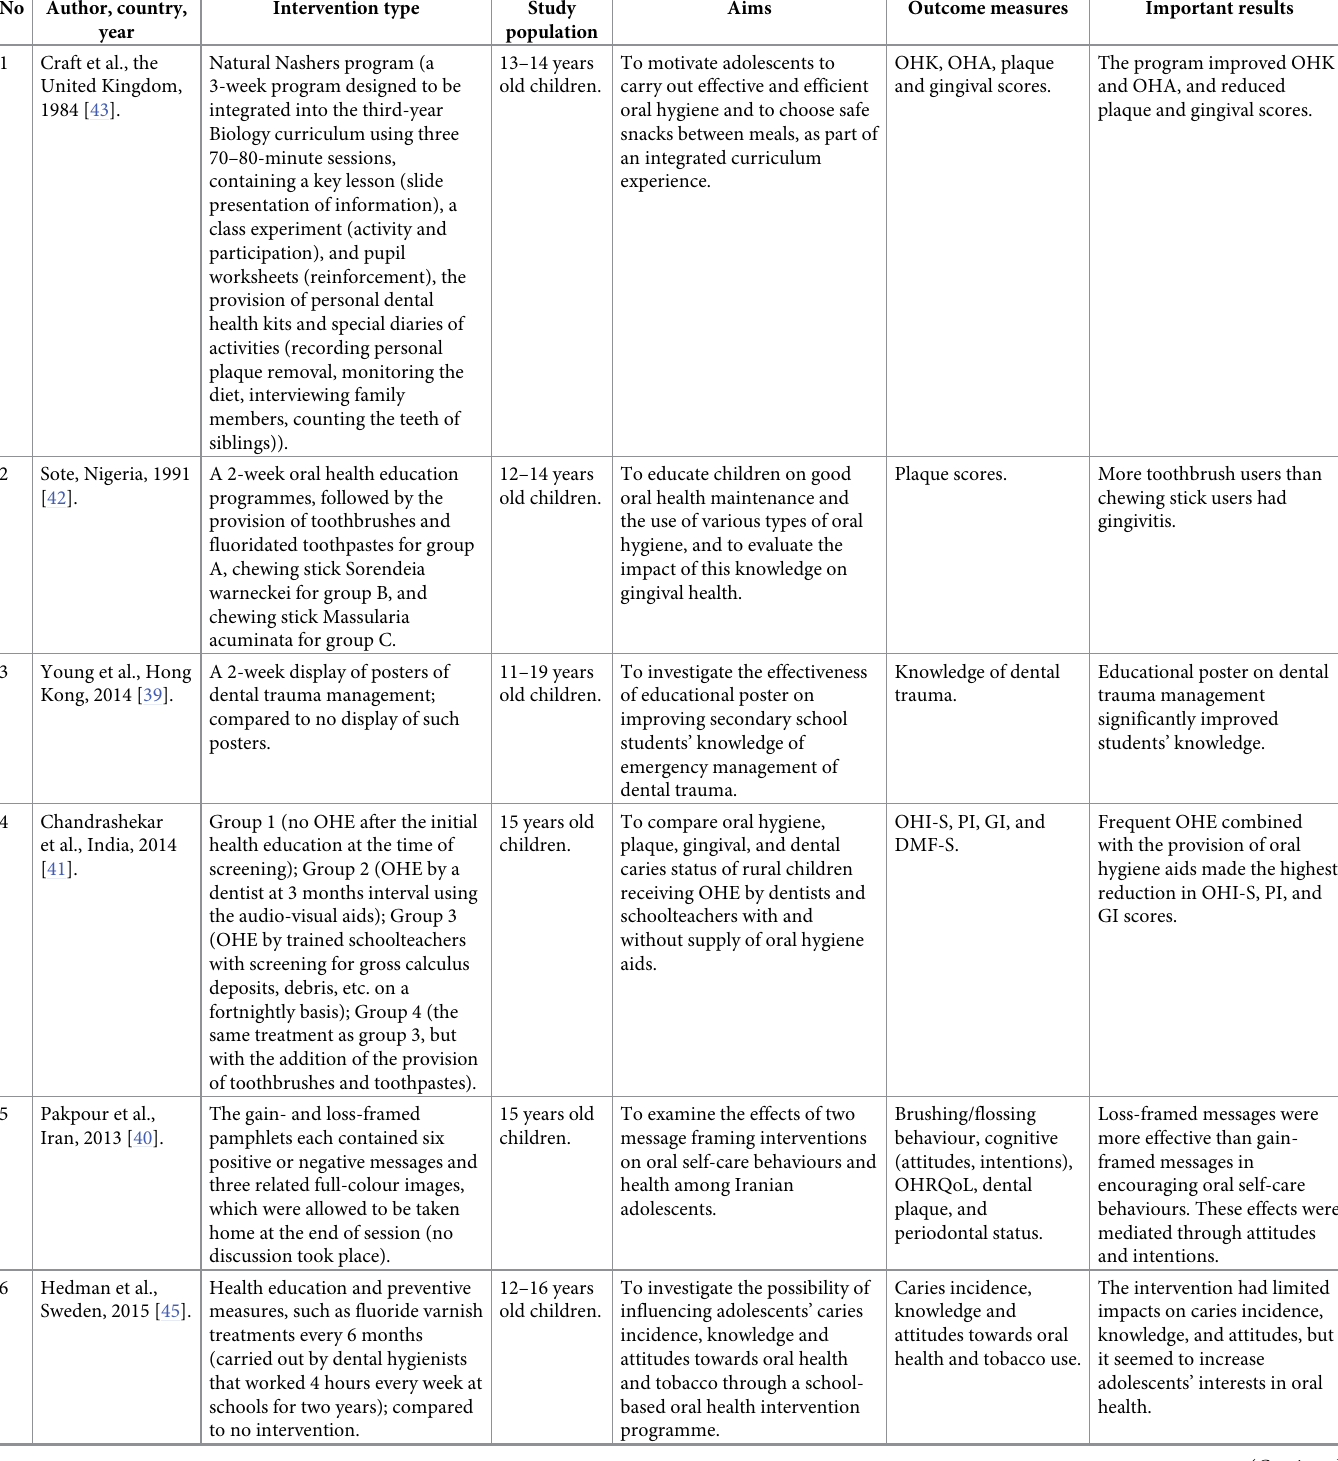
Table 3. The summary of studies conducted in high